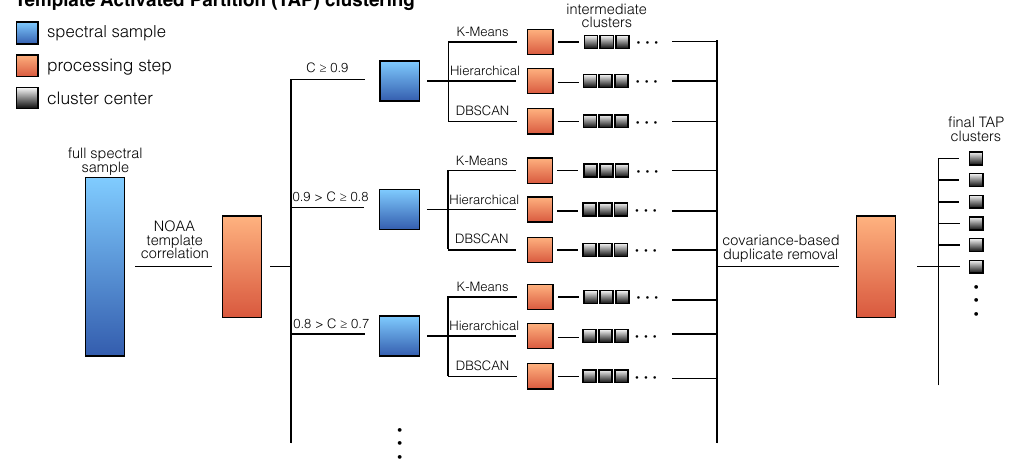
Figure 11. An illustration of the Template-Activated Partition (TAP) clustering approach. From left to right, the full spectral sample is partitioned into subsets according to the correlation with NOAA templates, each subset is independently clustered by three unsupervised clustering methods, and the results are pooled with duplicates removed to form the final TAP cluster centers.